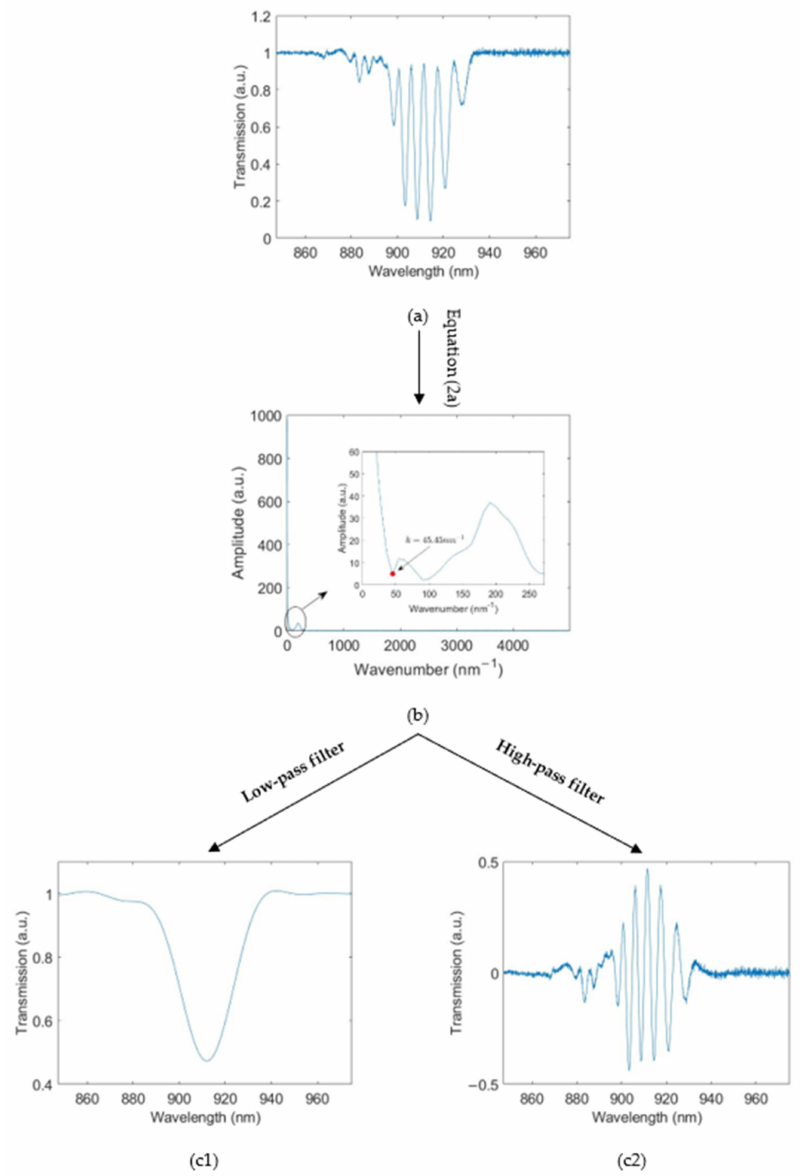
Figure 3. Signal processing: ( a ) transmission spectrum; ( b ) frequency domain representation of the transmission spectrum; ( c1 ) envelope; ( c2 ) high − frequency components. The wavenumber calculation is shown in the Supplementary Materials (Section